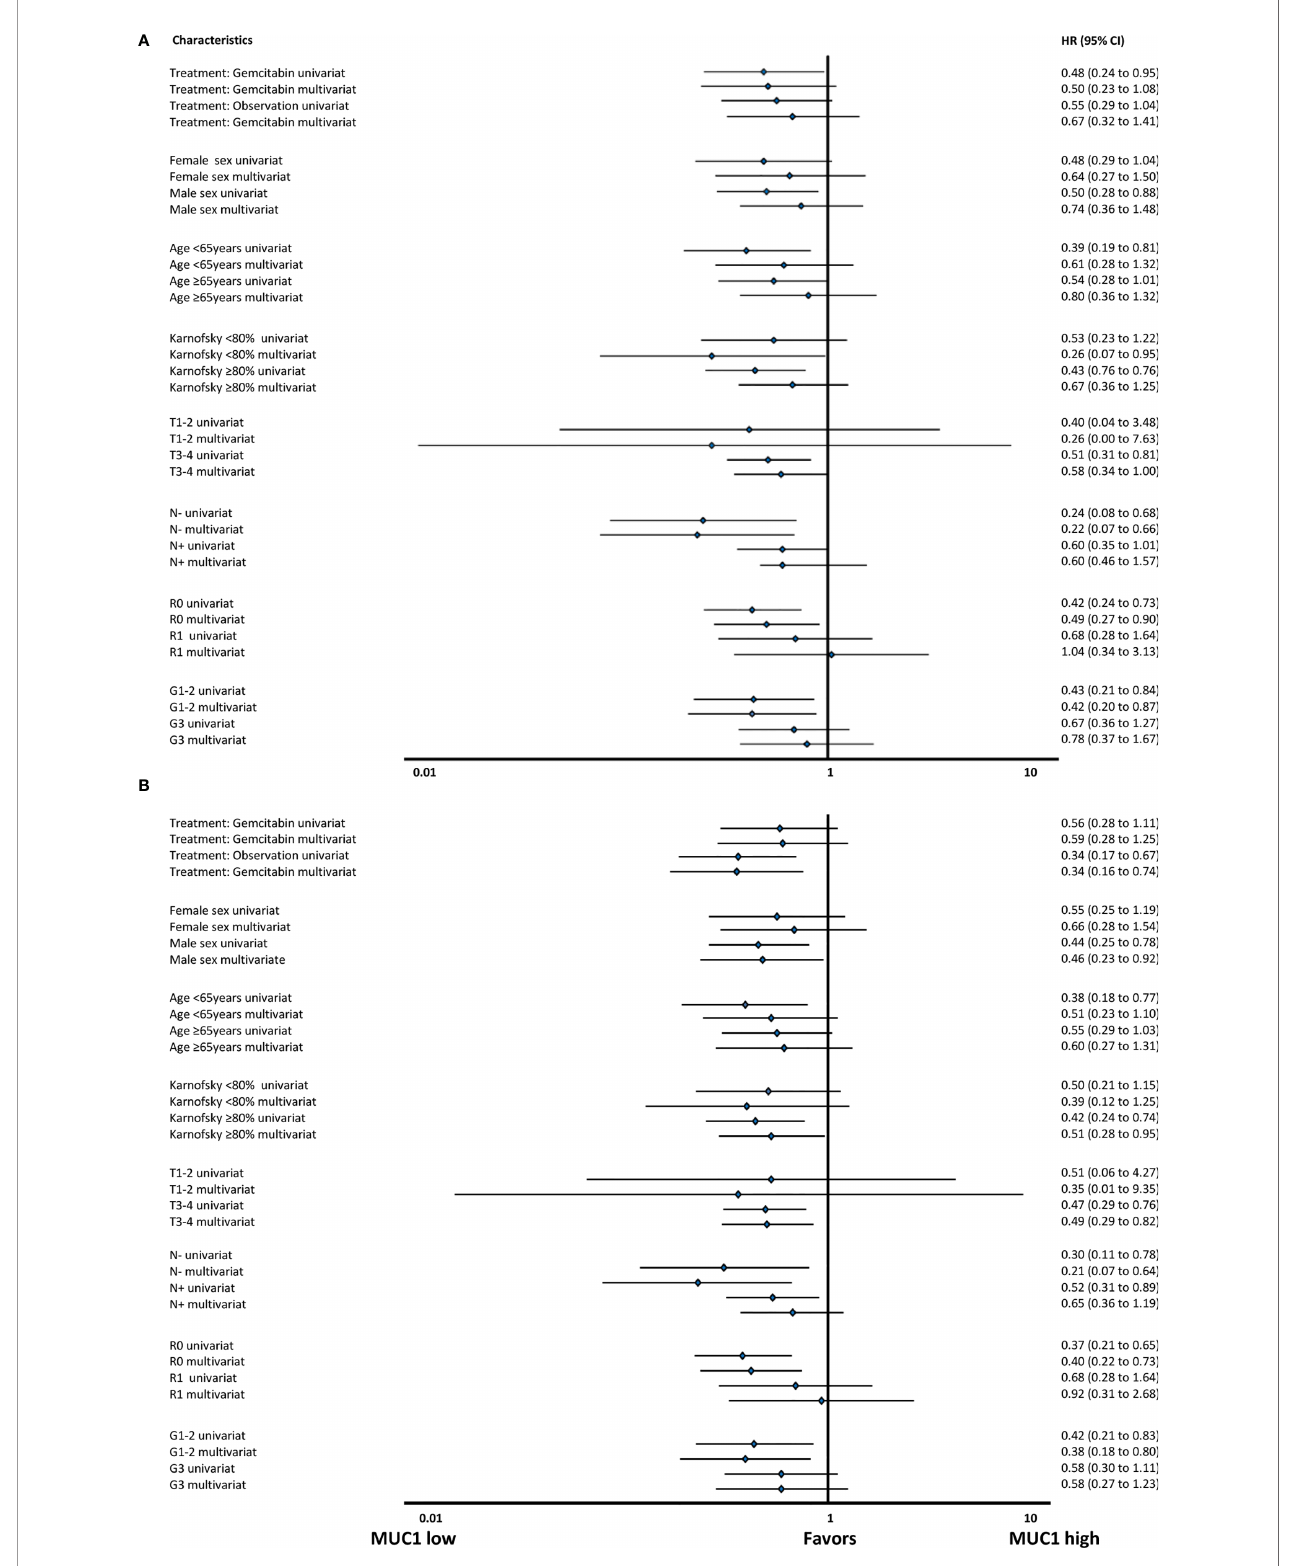
FIGURE 4 | Survival analyses in subgroups for (A) disease free survival and (B) overall